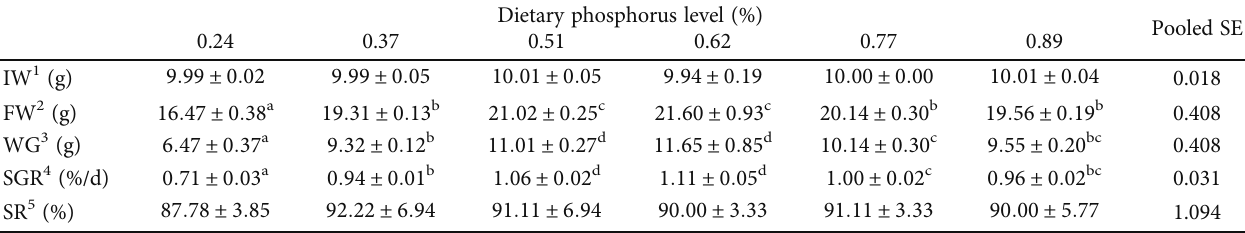
Table 2: Growth performance of A. japonicus fed experimental diets with di ff erent phosphorus levels.